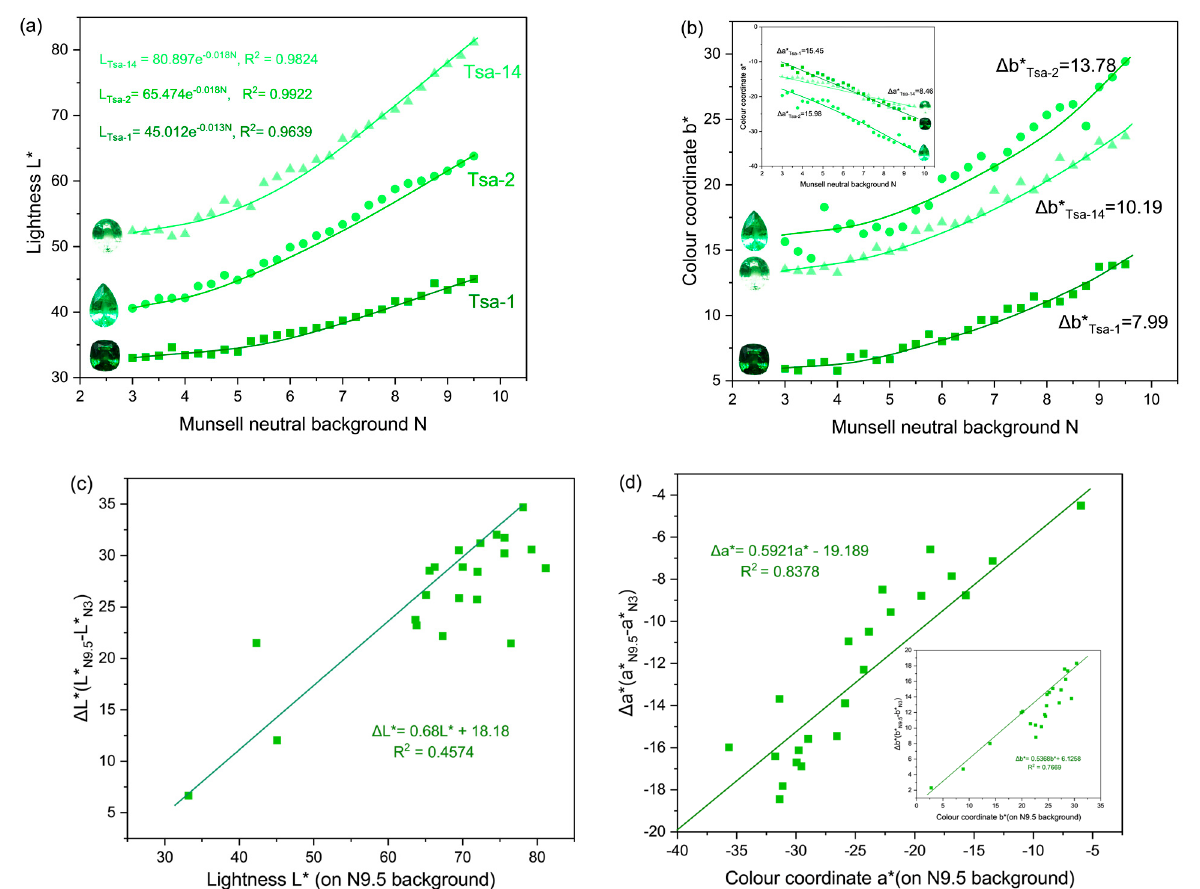
Figure 6. ( a ) Lightness L* change of three samples with different colors under different Munsell neutral backgrounds; ( b ) color coordinate a* and b* changes of the three samples with different colors under different Munsell neutral backgrounds; ( c ) the correlation between L* (on N9.5 background) and Δ L* (L* N9.5 − L* N3 ); ( d ) the correlation between a*, b* (on N9.5 background) and Δ a*, Δ b*.